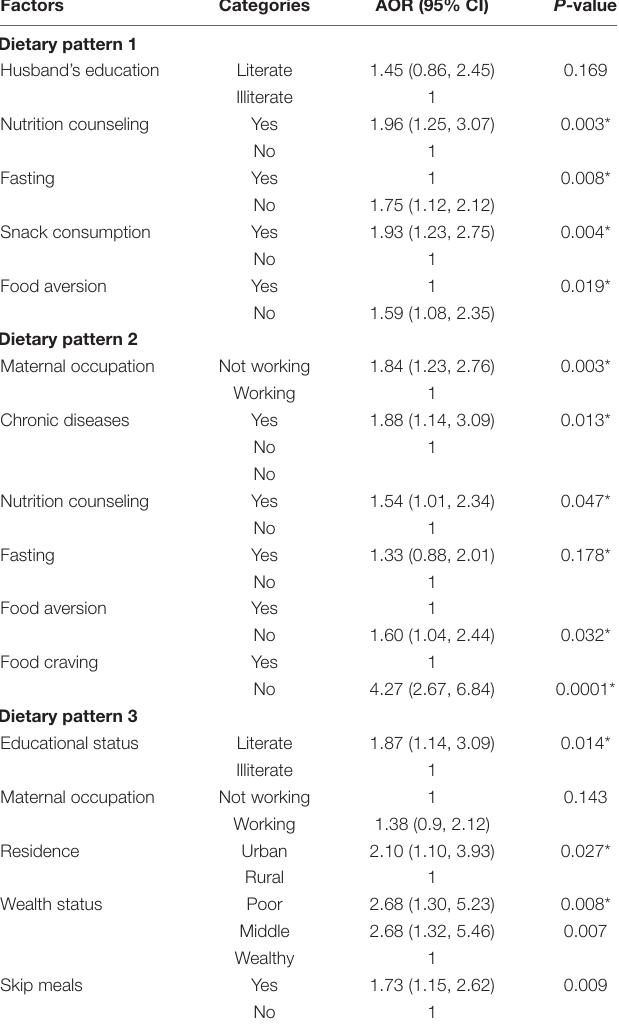
TABLE 2 | Multivariable OLS for factors associated with major dietary patterns among women in Dire Dawa